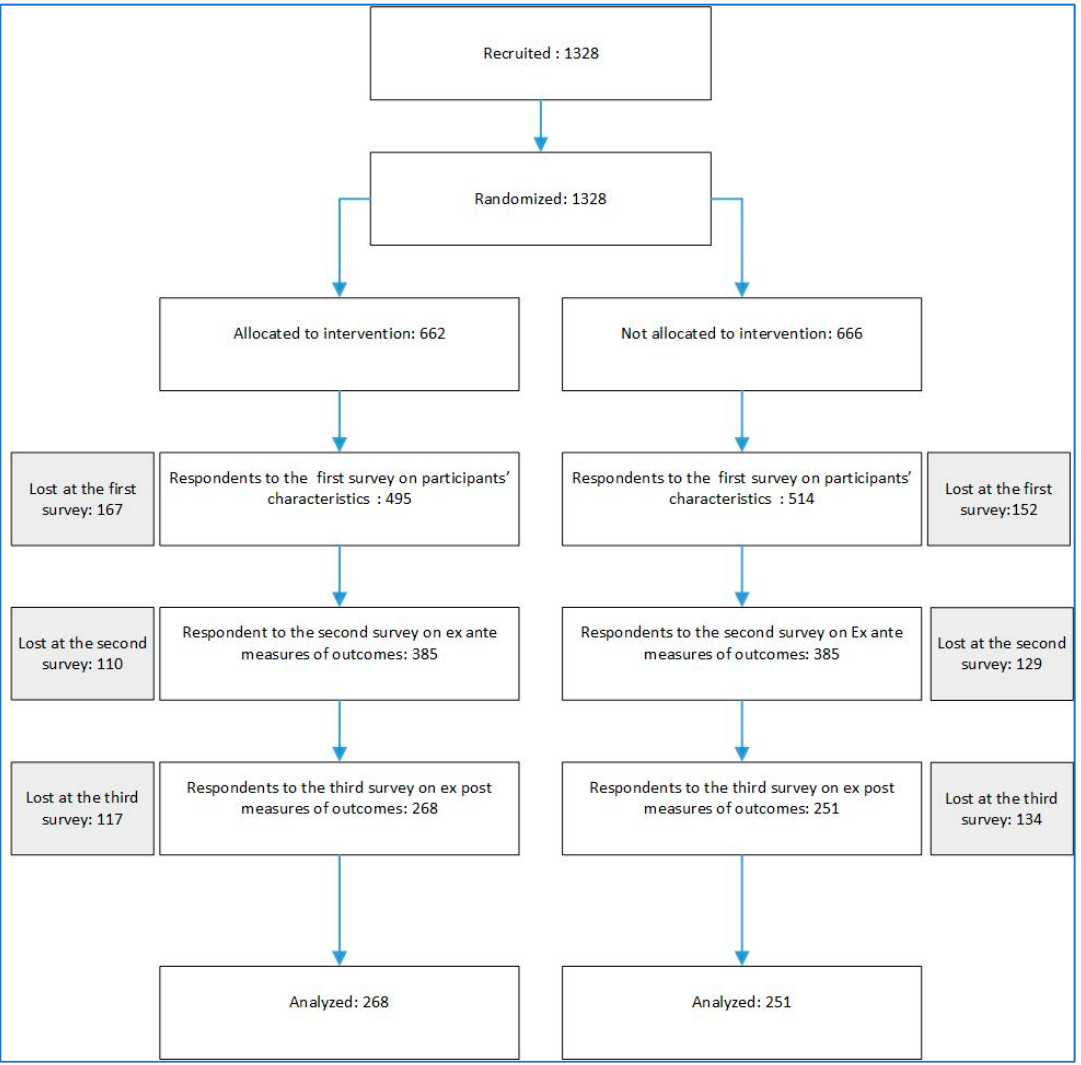
Figure 1. Consort Chart for automated phone smog warning system (APWS) experiment.